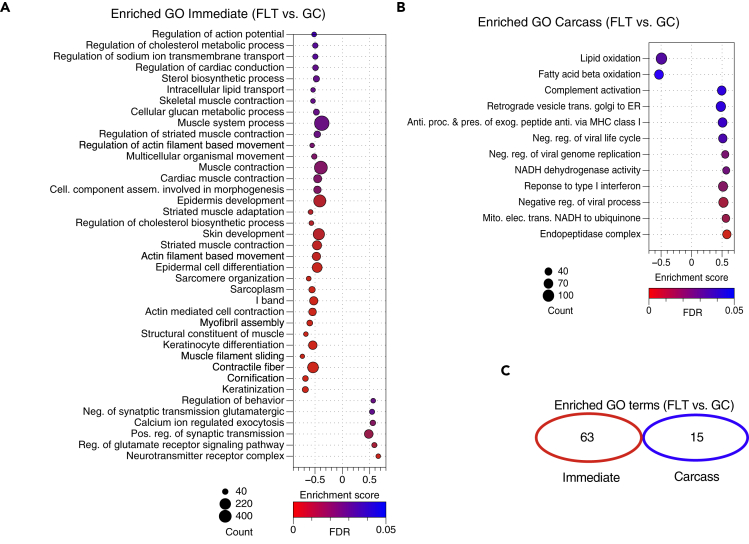
Enriched Gene Ontology (GO) Terms between the RR-1 NASA Spaceflight and Ground Control Groups(A) Enriched GO terms between the spaceflight (FLT) and ground control (GC) immediate samples identified by Gene Set Enrichment Analysis (gene set permutation).(B) Enriched GO terms between the spaceflight (FLT) and ground control (GC) carcass samples identified by Gene Set Enrichment Analysis (gene set permutation). In both A and B, the more positive or negative the enrichment scores, the higher the expression in spaceflight or ground control samples, respectively. Dot size indicates number of genes within each GO term. Dot color indicates false discovery rate (FDR). GO terms displayed met the thresholds of FDR <0.05, NOM p < 0.01, gene set size >40.(C) Venn diagram of the number of enriched GO terms identified in Carcass (blue) and Immediate (red) samples when comparing spaceflight (FLT) and ground control (GC) samples. GO terms in Venn diagram met the threshold of FDR <0.05, NOM p < 0.01. Data are from GLDS-48.